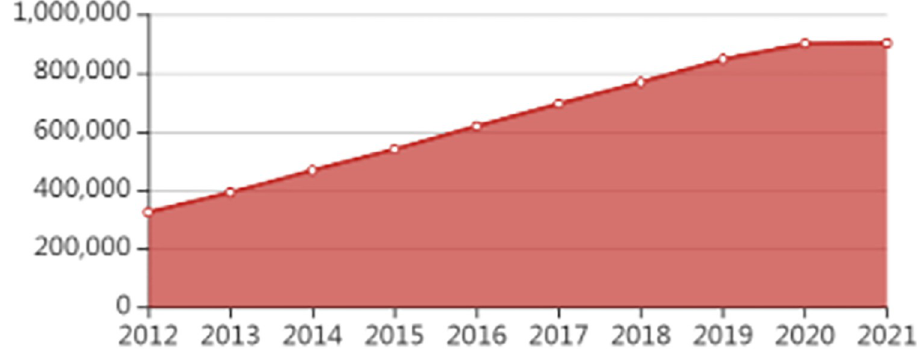
Fig 1. Source: China Philanthropy Times